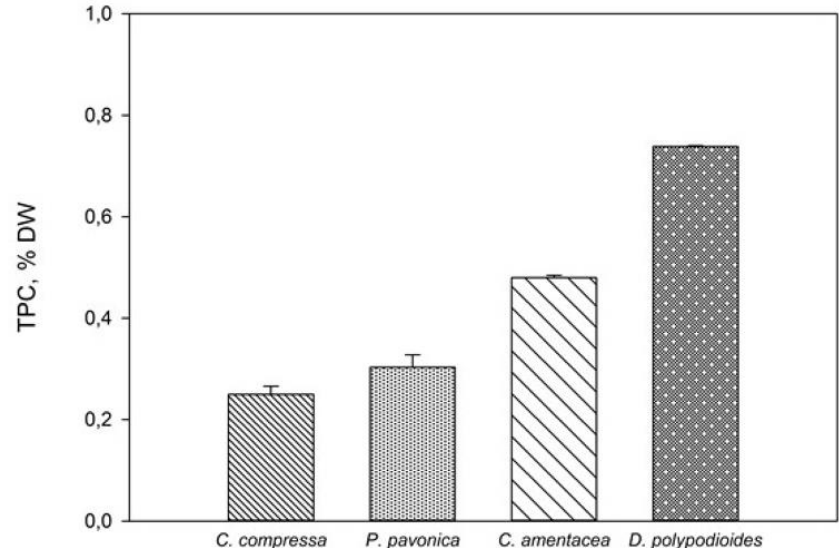
Figure 3. Variations of total phenolic content (TPC) in four Mediterranean brown algae. Bars represent mean ± standard deviation ( n = 5) (from [78]).